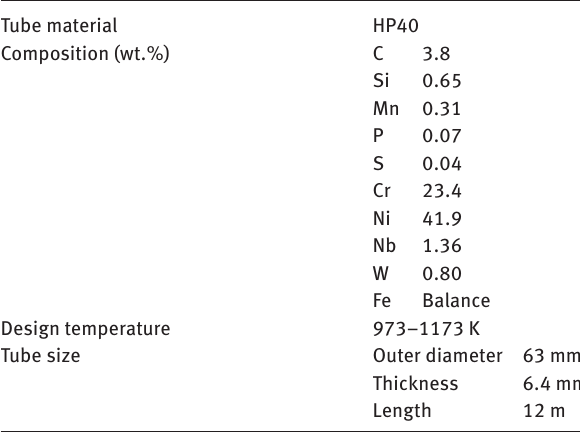
Table 6: Material specification of ethylene cracking tubes of sample and design parameters [21].